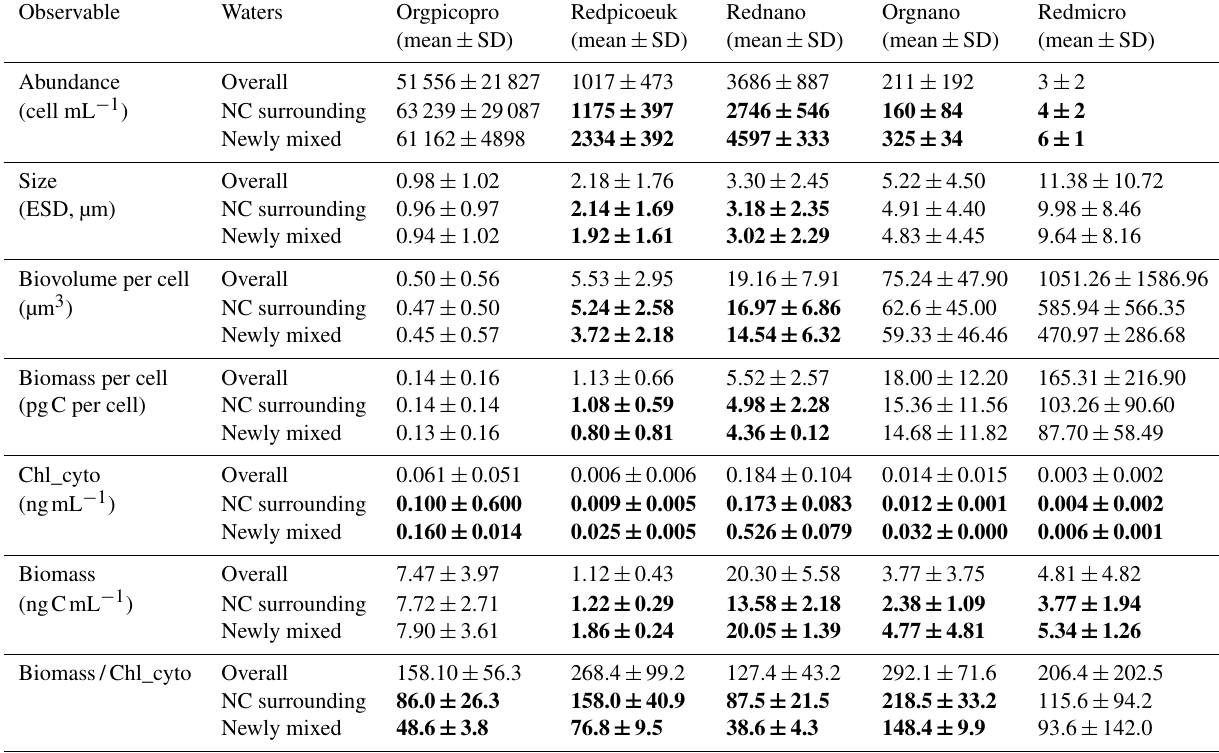
Table 2. The mean and standard deviation of surface abundance, size (equivalent spherical diameter, ESD), biovolume per cell, biomass per cell, Chl a per unit volume (Chl_cyto), biomass per unit volume, and the biomass/Chl_cyto ratio for the all waters sampled (“Overall”, n = 400), the NC surrounding waters ( n = 20), and the newly mixed waters ( n = 43) (see Fig. 7) for the five AFCM phytoplankton groups identified. The surrounding NC waters correspond to the surface NC waters acquired 6h before and after the ship entered newly mixed waters. A moving block bootstrap test between NC surrounding and newly mixed waters reveals significant differences, and bold values are significantly different at a Bonferroni-corrected 5%